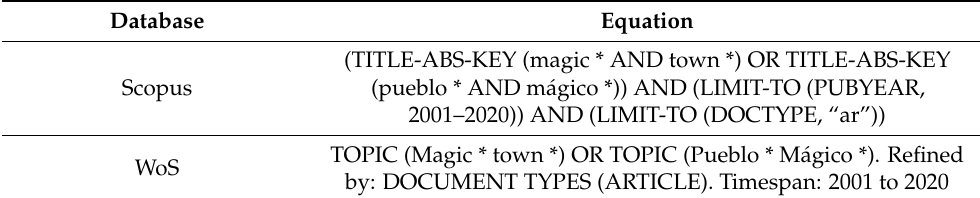
Table 1. Search equations by database. Database Equation